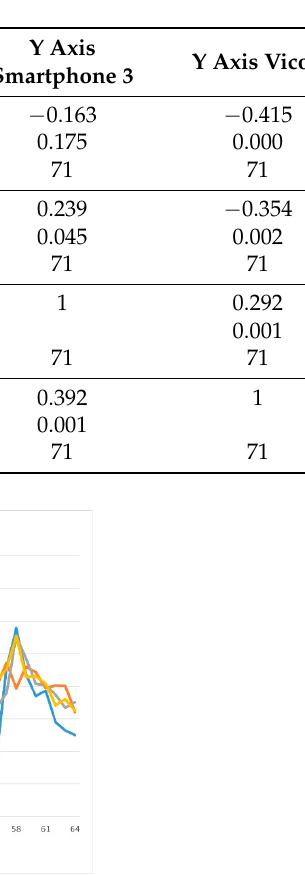
Table 4. Pearson r correlations from each device linear acceleration’s data on the Y axis.